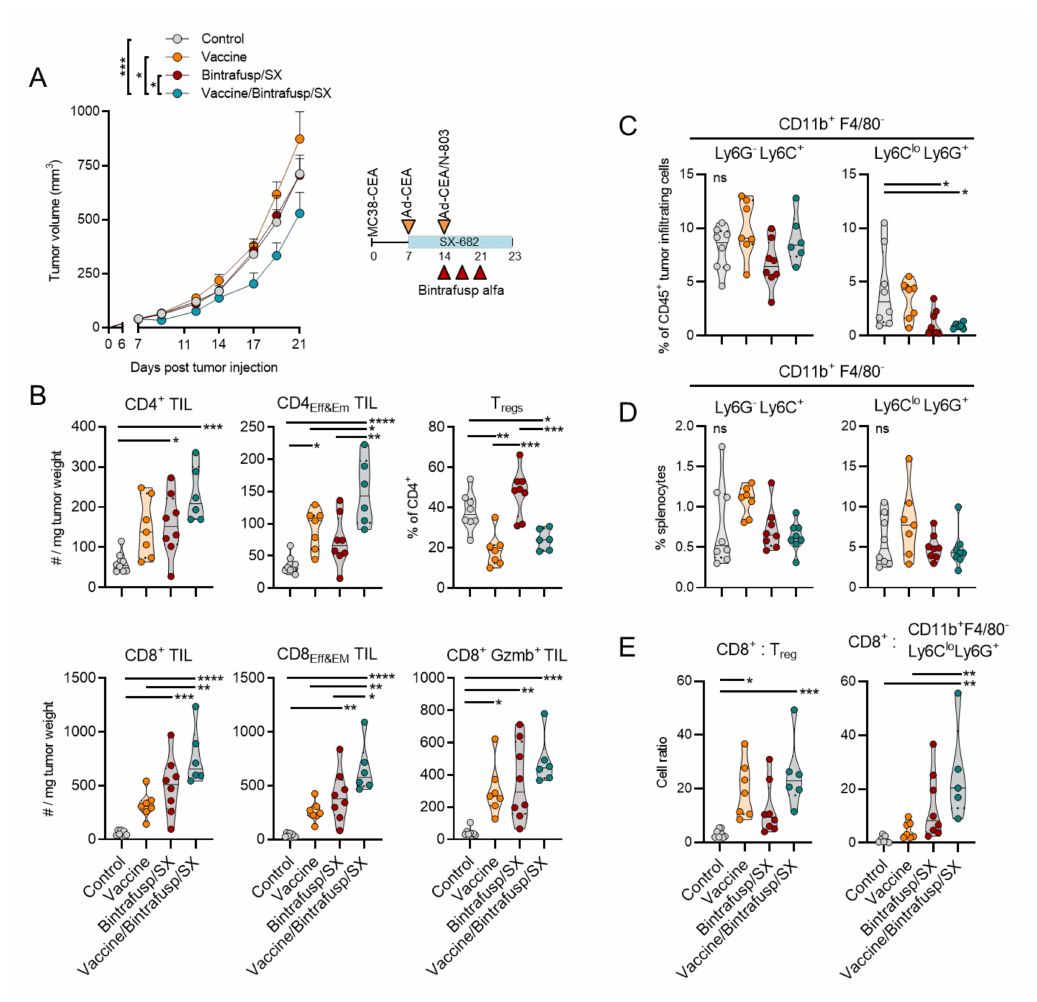
Figure 1. Vaccine synergizes with Bintrafusp alfa/SX-682 and increases TIL in MC38-CEA tumors. ( A ) CEA.Tg mice were injected s.c. with 3 × 10 5 MC38-CEA in the flank. On day 7, mice were started on a control or SX-682 diet (200 mg/kg body weight/day), and on days 14, 17, and 21 mice received i.p. injections of 200 µ g bintrafusp alfa. Priming vaccine dose of s.c. Ad-CEA (1 × 10 10 viral particles) was administered on day 7 with a boosting dose of Ad-CEA/N-803 (1 × 10 10 viral particles, N-803, 1 µ g, s.c.) on day 14. Graph shows average tumor growth and error bars indicate SEM of biological replicates; n = 8 mice/group. * p ≤ 0.05; *** p ≤ 0.001 for two-way ANOVA in ( A ). Control indicates mice that were left untreated and fed a base diet without SX-682. Tumors ( B , C ) and spleens ( D ) were harvested and analyzed by flow cytometry on day 23 for lymphocytes ( B ) and myeloid cells ( C , D ). ( E ) Cell ratios comparing the number of cells per mg tumor weight were also calculated. Individual points represent data from one tumor. ns, not significant; * p ≤ 0.05; ** p ≤ 0.01; *** p ≤ 0.001; **** p ≤ 0.0001 for one-way ANOVA followed by Tukey’s post hoc test in ( B – E ). i.p. = intraperitoneal. s.c. = subcutaneous. TIL = tumor-infiltrating lymphocyte. Tregs = regulatory T